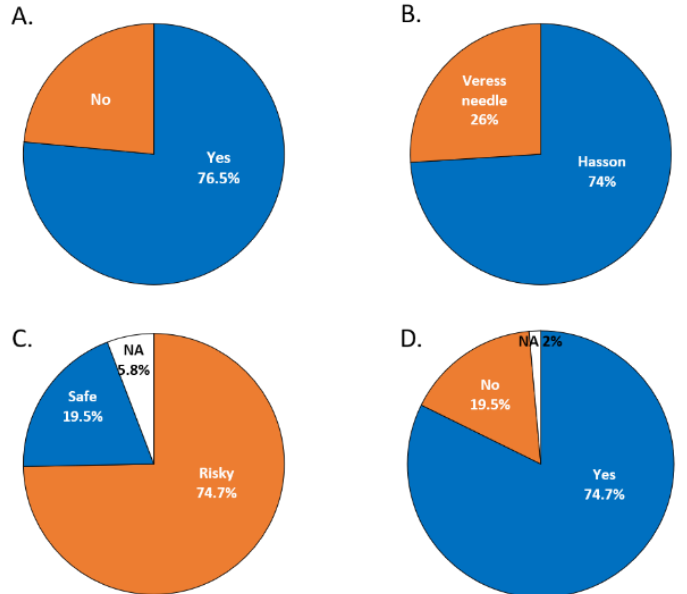
Figure 10. Peritoneal access survey among 150 surgeons. ( A ) Prior experience of Veress needle placement. ( B ) The current practice of peritoneal access. ( C ) Physicians’ opinions regarding the use of the Veress needle. ( D ) Will surgeons use Veress needle if the puncturing process could be visu- alized?